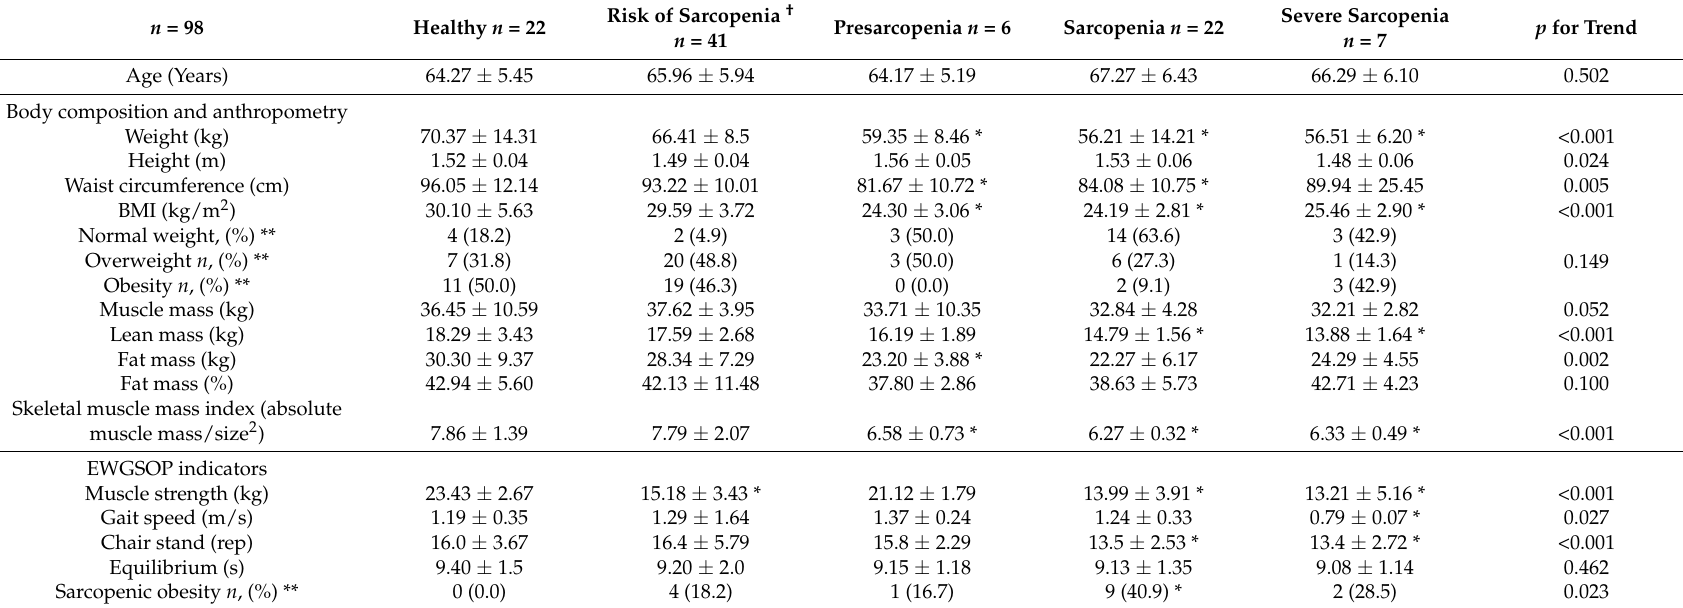
Table 3. Distribution of body composition variables according to the sarcopenia stages from the